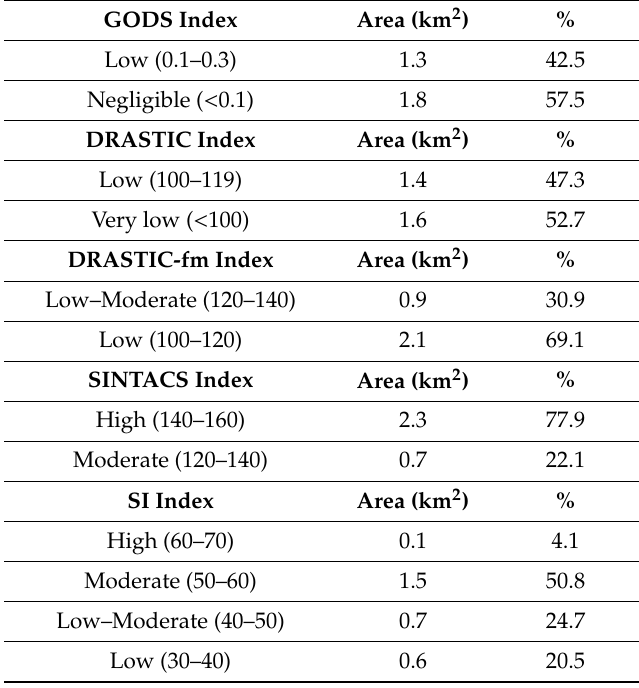
Table 2. Urban groundwater vulnerability assessment in Penafiel urban area (NW Portugal): A statistical overview of GODS, DRASTIC, DRASTIC-fm, SINTACS, and SI